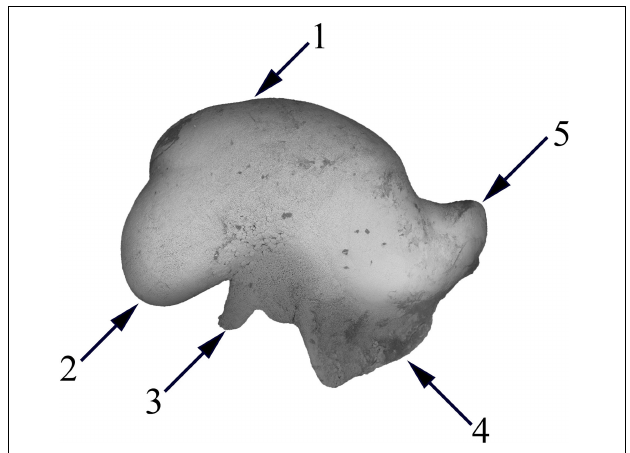
FIGURE 5 | Statolith extracted from Taonius borealis . (1) Lateral dome; (2) dorsal dome; (3) spur; (4) wing; (5)